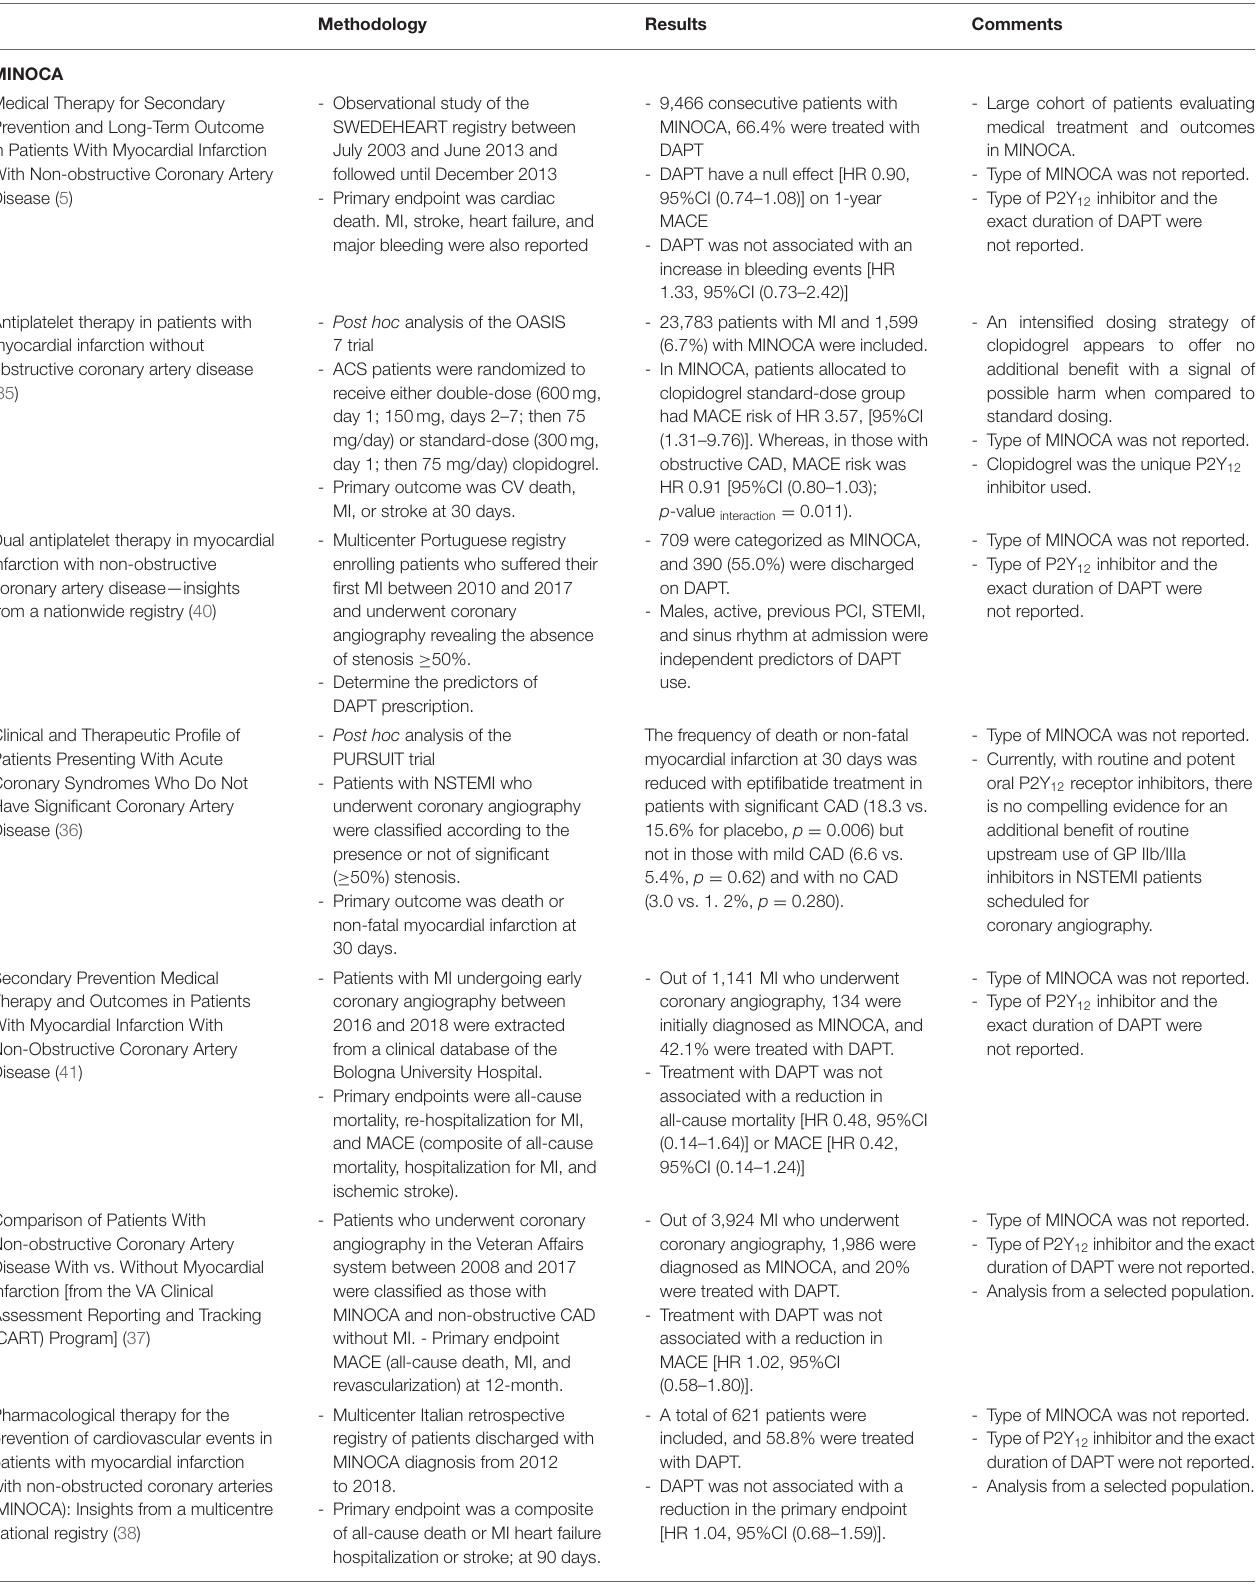
TABLE 2 | Selection of studies assessing the role of antiplatelet therapy in